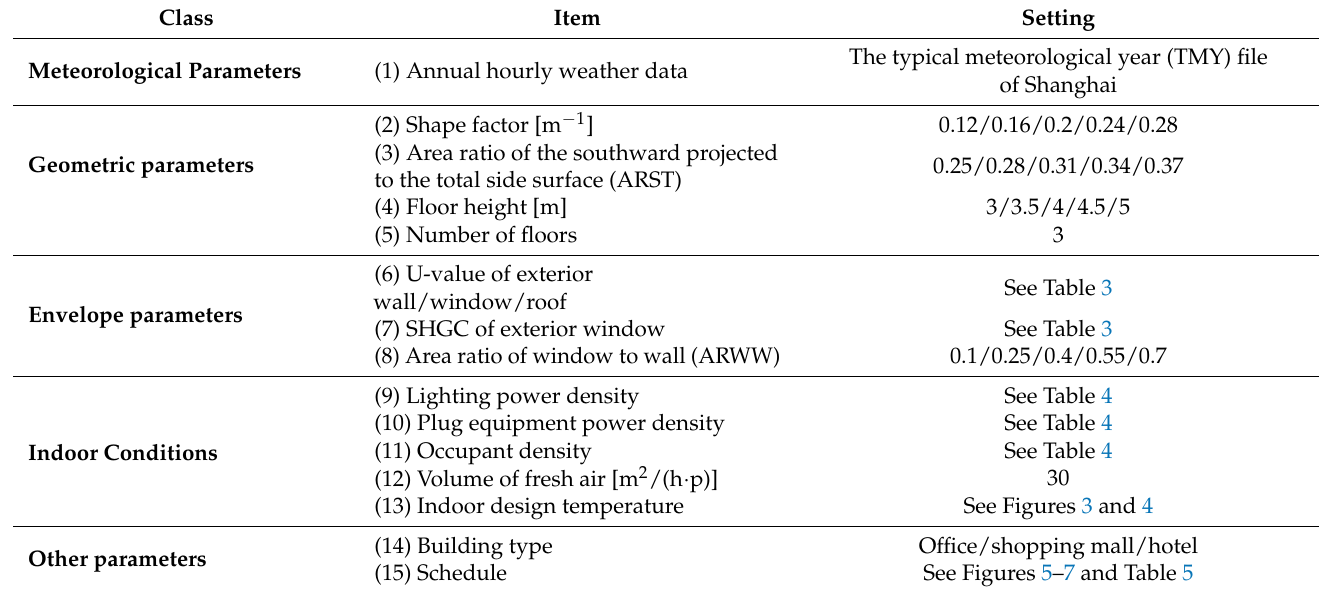
Table 2. Parameter settings of the building models in database.